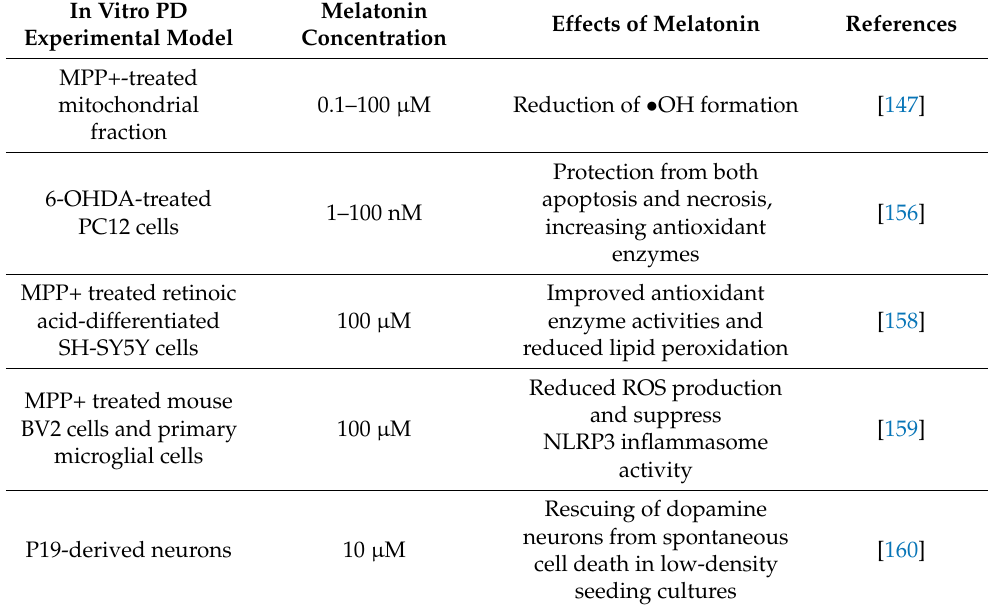
Table 5. Effects of melatonin on oxidative stress in in vitro PD